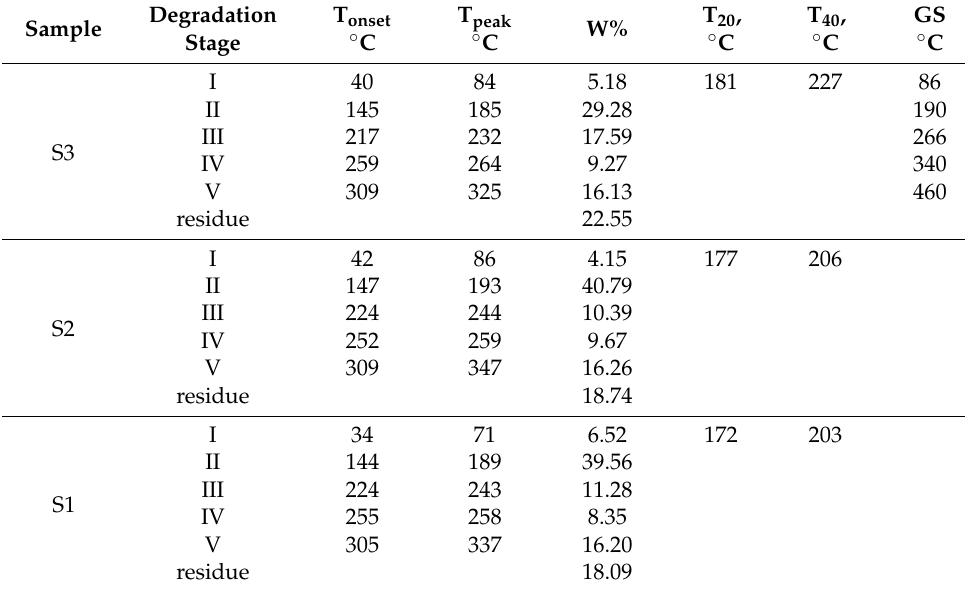
Table 1. Thermal